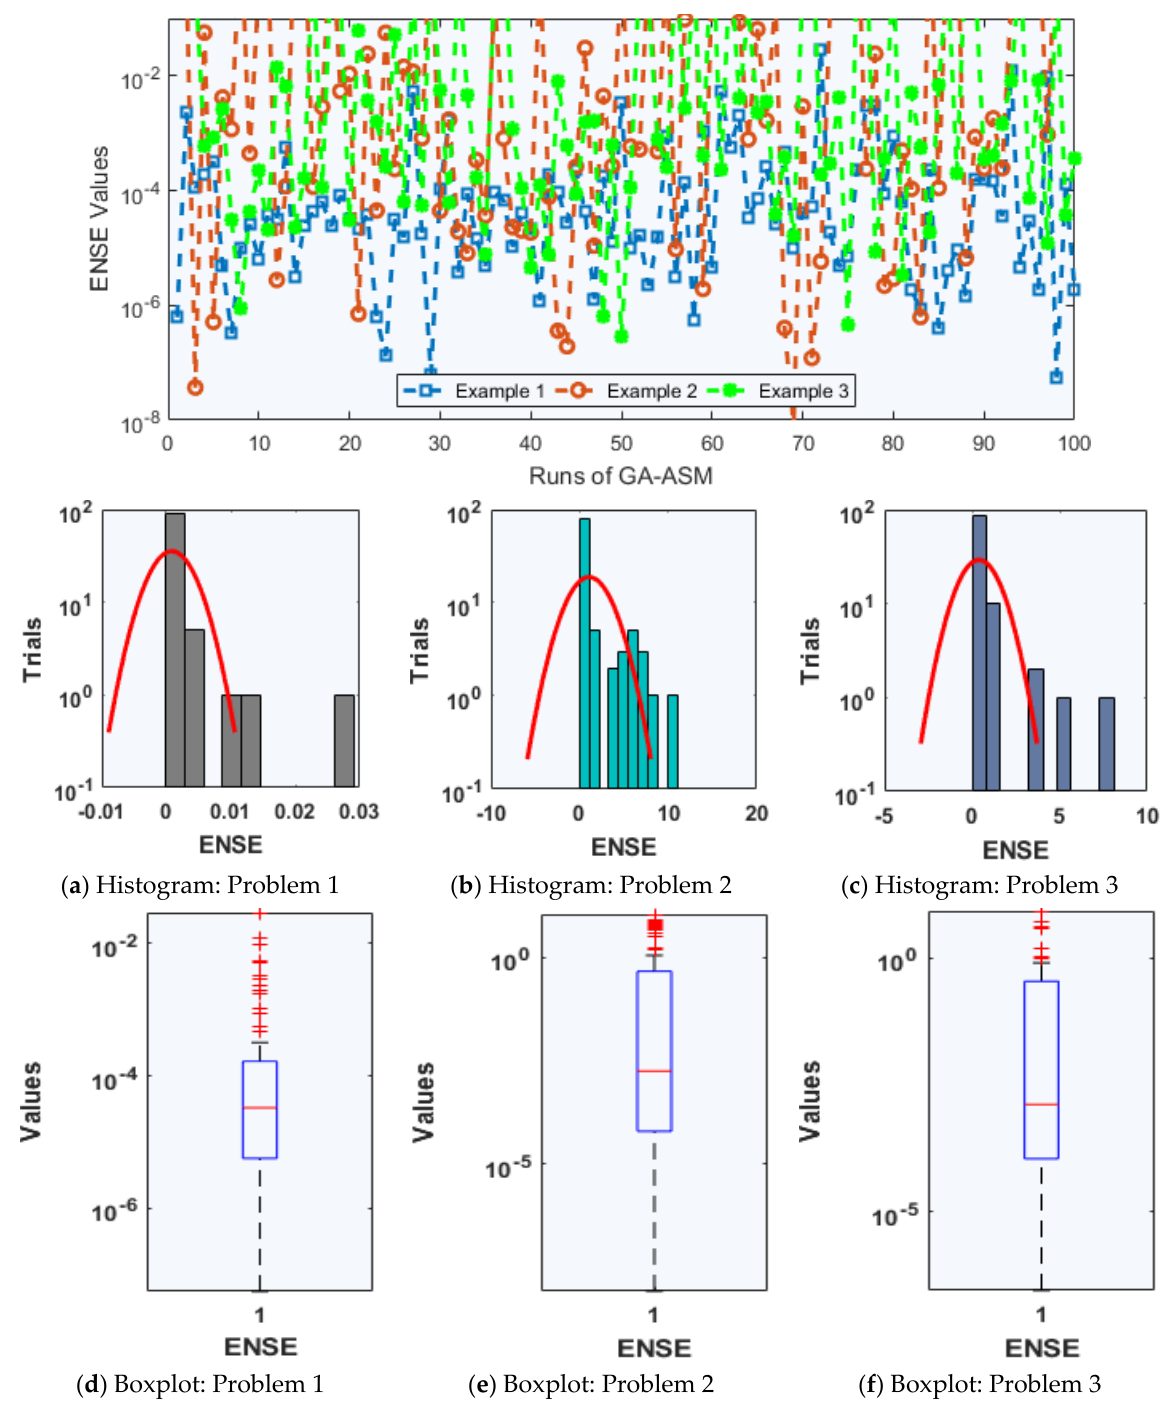
Figure 6. Convergence performances for the solution of Problems 1–3 based on the second kind of NLE-PDSM using ANN-GAASM in terms of ENSE values; boxplots and histograms for 10 neurons. ENSE on y -axis and independent executions on x -axis.